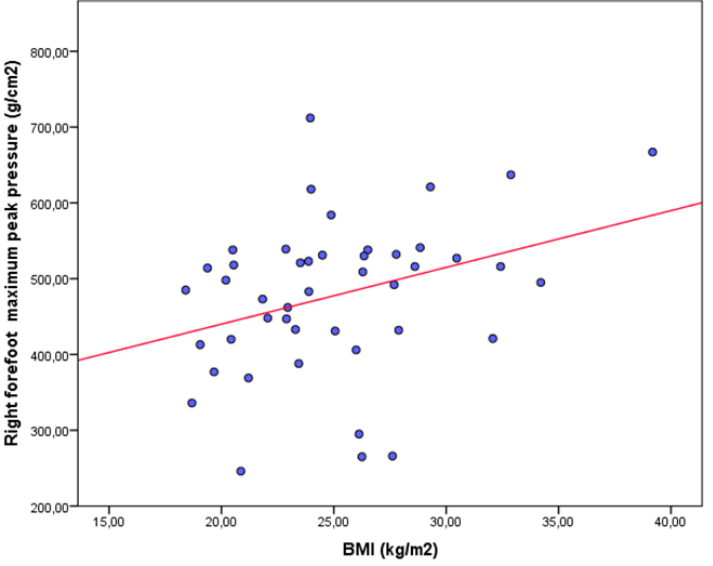
Figure 2. Scatter plot showing a significant positive weak correlation between the right forefoot maximum peak pressure and BMI in patients with asthma.